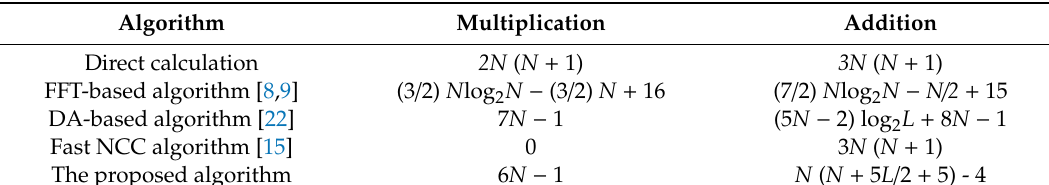
Table 1. The compassions of computational complexity.